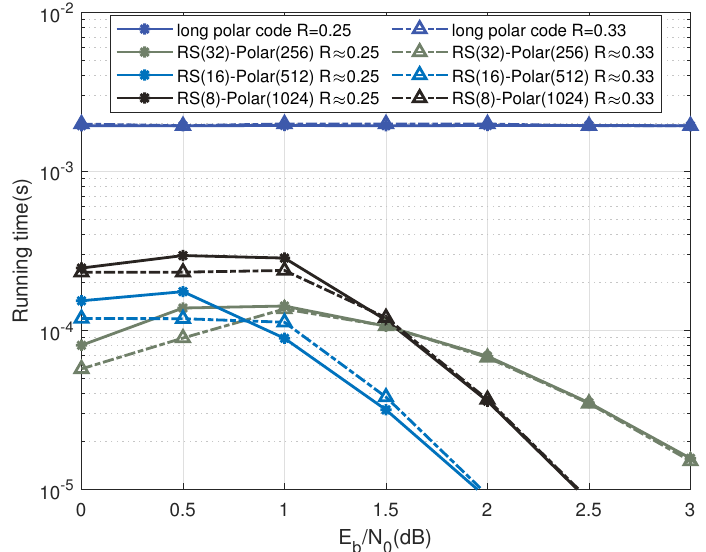
Figure 9. Single average running time when decoding the UEP-RS-polar scheme and long polar codes over AWGN channels with a code length og 8192 bits. Each runtime is averaged by 10 5 trails, executed on the MATLAB R2021a software with an Intel(R) Core(TM) i7-7700 CPU @ 3.60